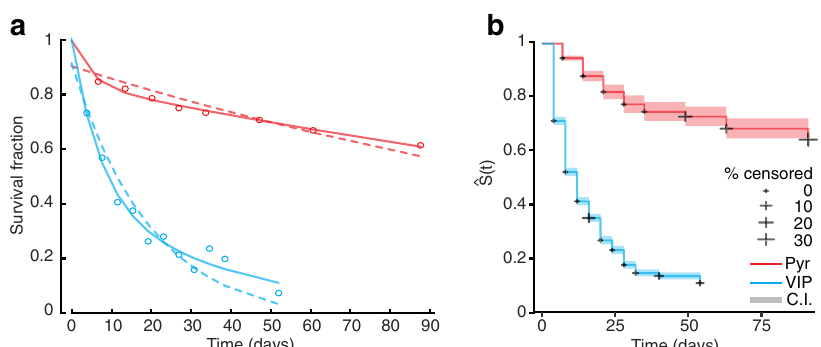
Fig. 4 Comparison of VIP spine dynamics with L2/3 pyramidal spine dynamics. a The survival fraction of spines that were present in the fi rst imaging session (day 0) from VIP (blue) and pyramidal neurons (red) were fi tted with single ( f t ð Þ ¼ ae bt , dashed lines) and two-exponential-sum ( f t ð Þ ¼ ae bt þ ce dt , solid lines) functions. The data for the two neuronal classes (circles) represent the average over mice. b The spine survival probabilities plotted as the Kaplan – Meier estimate. Shaded areas represent 95% con fi dence